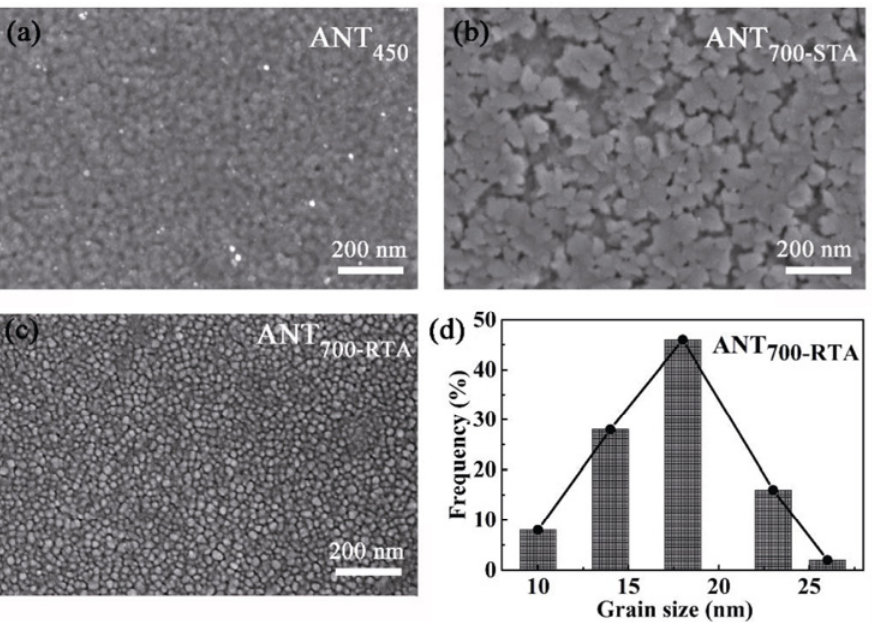
Fig. 2 Surface SEM images of (a) ANT 450 , (b) ANT 700-STA , and (c) ANT 700-RTA films. (d) Grain size distribution chart obtained from (c).